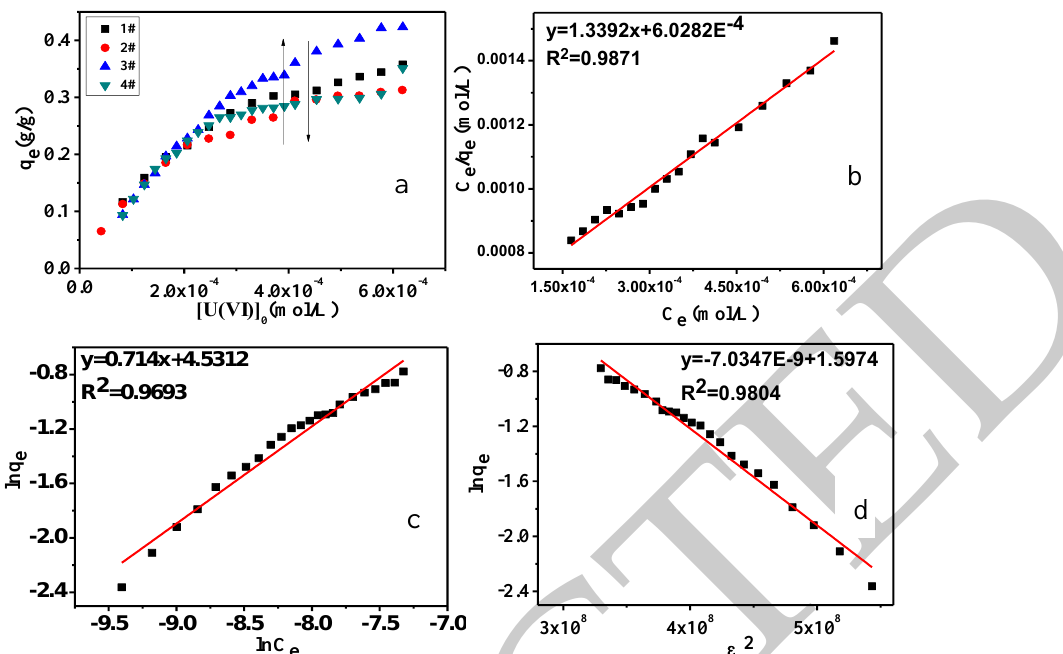
Figure 11. E ff ect of the initial U(VI) concentration on the adsorption of U(VI) onto β -CD- g -(MAH- co -AO) ( a ), and Langmuir model ( b ) Freundlich model ( c ) and D-R model ( d ) (Conditions: pH = 4.00 ± 0.05, I = 0.50 M NaNO 3 , t = 4 h, m / V = 0.20 g/L).